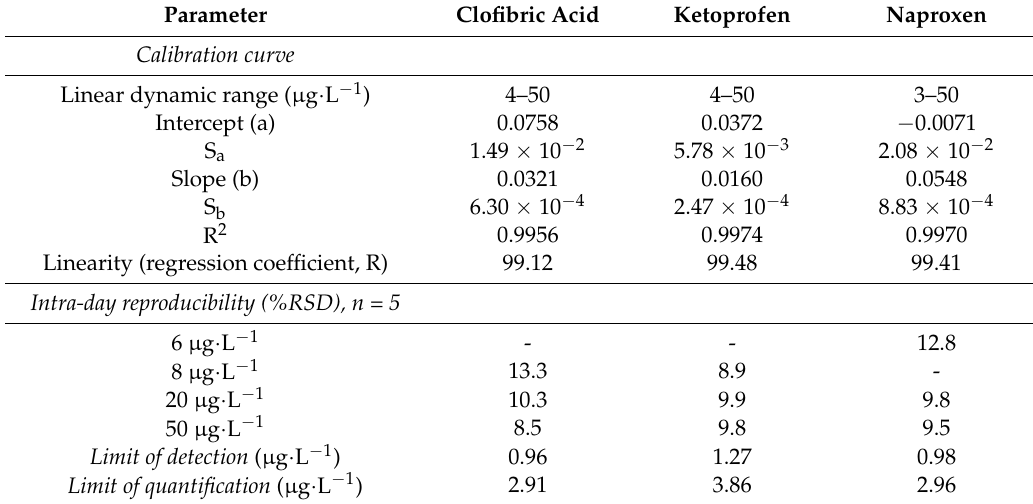
Table 5. Analytical parameters of the studied acidic drugs using SPME-Acetonitrile Stacking-CZE-DAD.